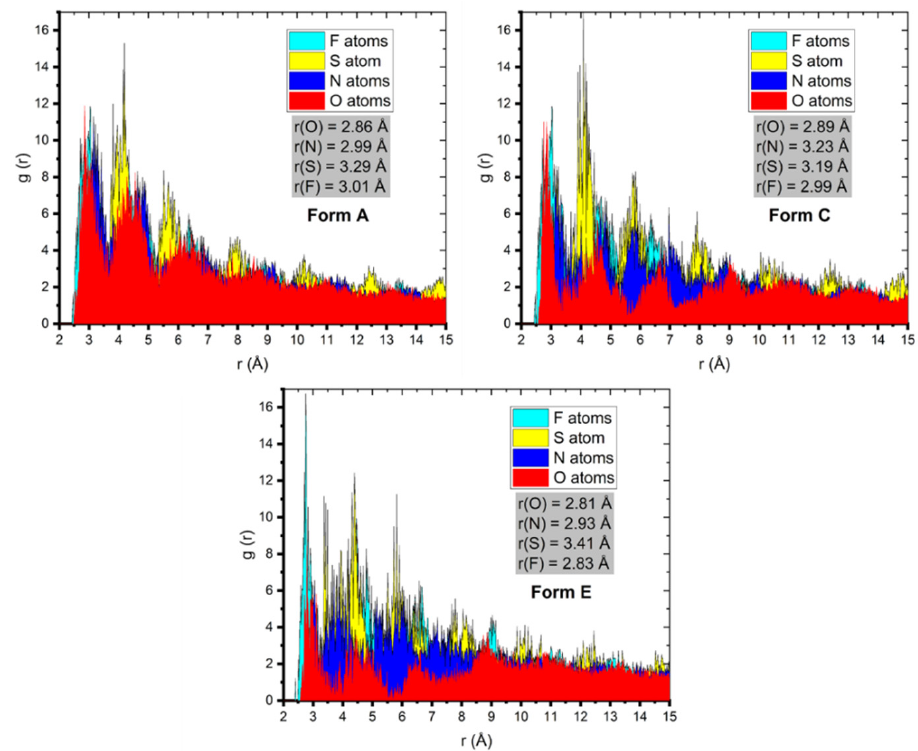
Figure 10. RDF oxygen, nitrogen, fluorine, and sulfur atoms for the Pantoprazole inhibitor onto the Fe (1 1 0) surface gained via MD.